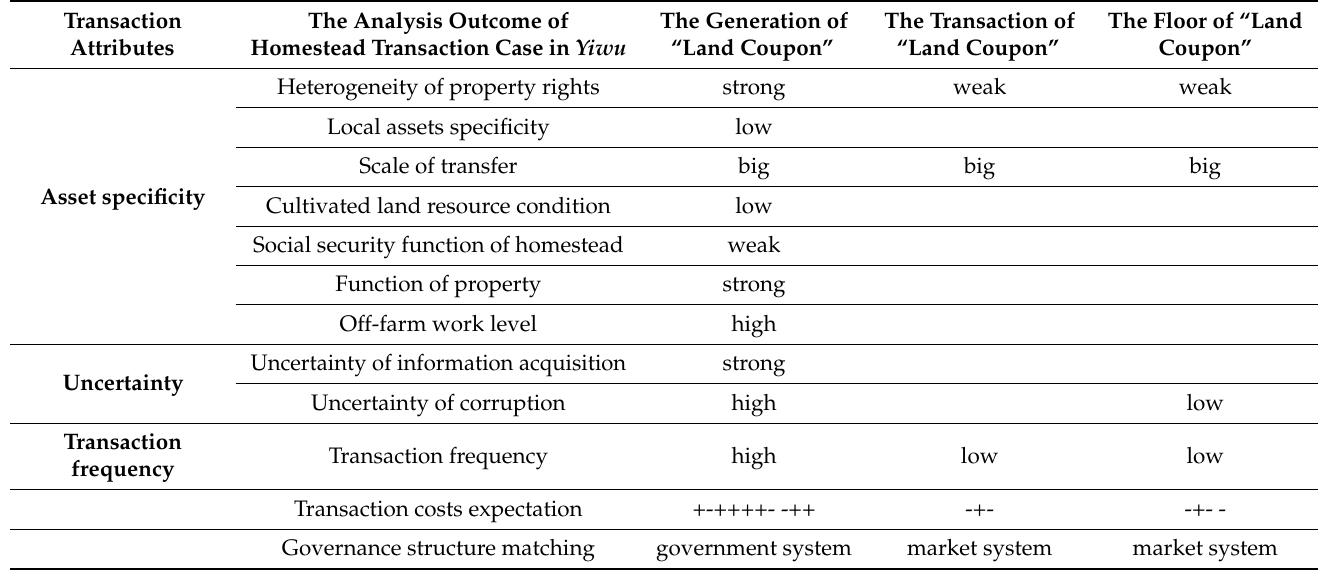
Table A4. The transaction attributes and the appropriate governance structures in Yiwu .